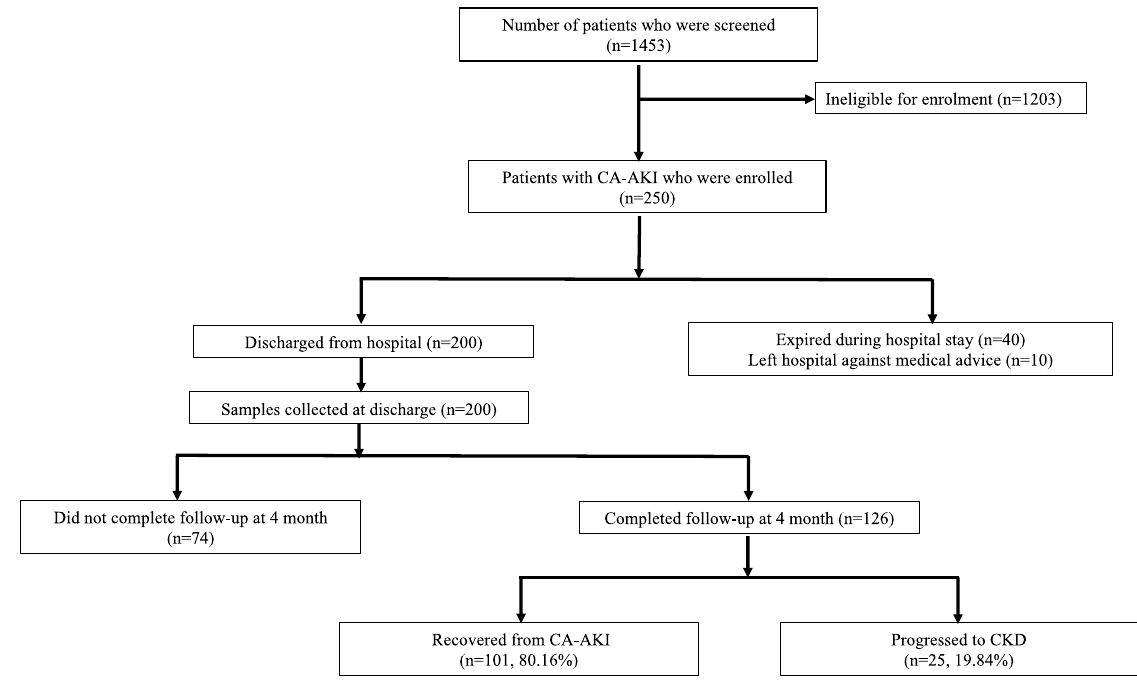
Figure 1. Study consort